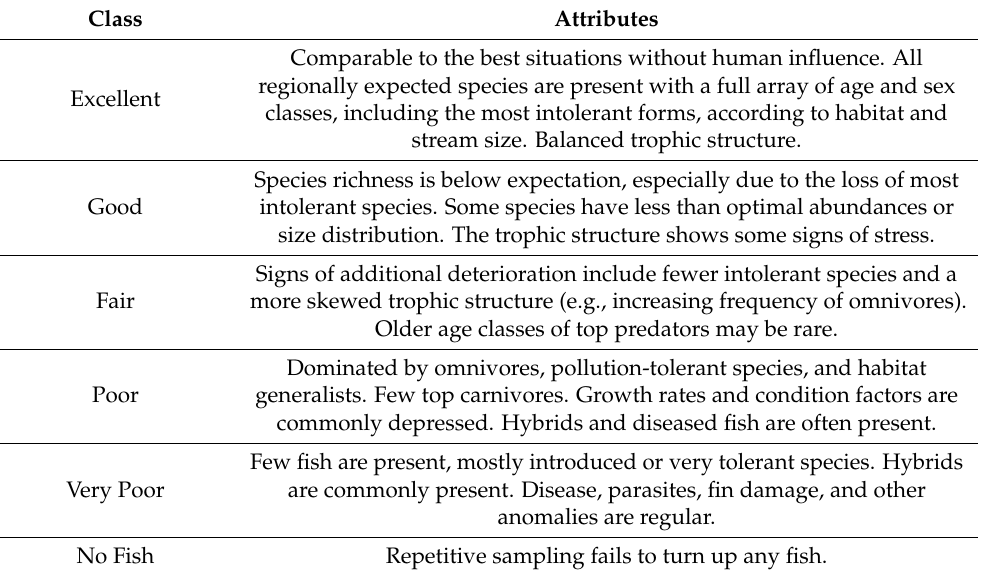
Table 2. Biotic integrity classes used in fish communities’ assessment with general descriptions and attributes; modified from